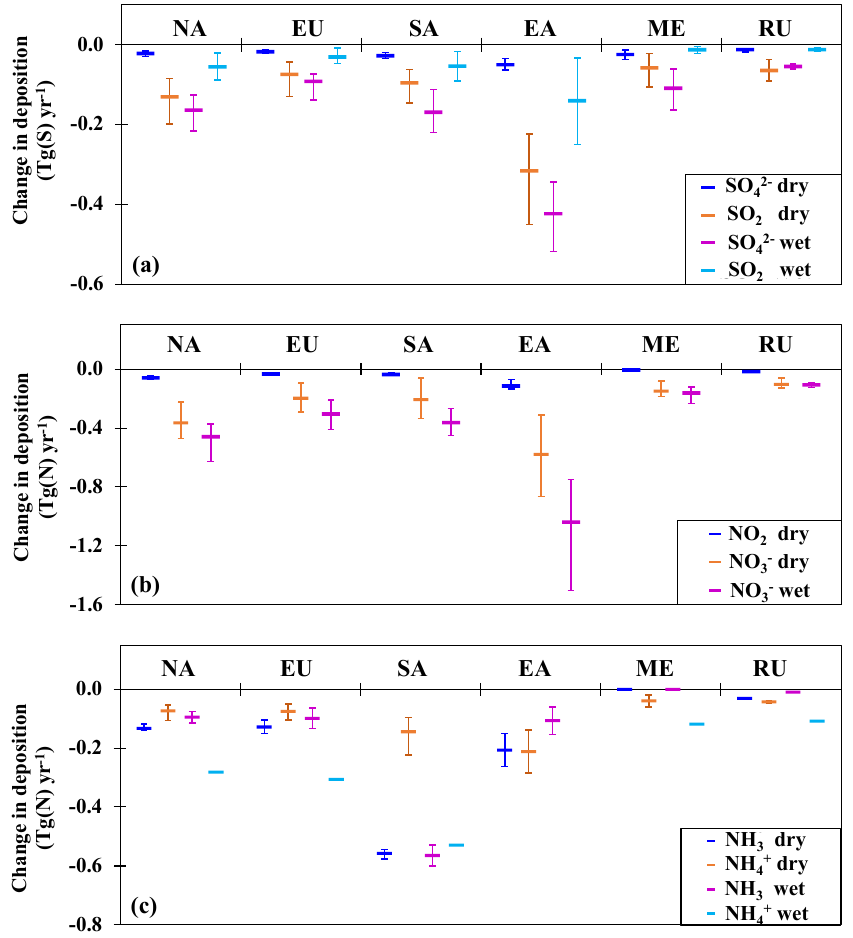
Figure 7. Inter-model variations in the change of wet and dry deposition (unit: Tg(S or N)yr − 1 ) under emission perturbation experiments. The values are global integrated changes in components of S and N deposition between base case and perturbation experiments from multi- model mean (MMM) results. The error bars are the max and min values among all models. Species without error bars are derived from results of a single